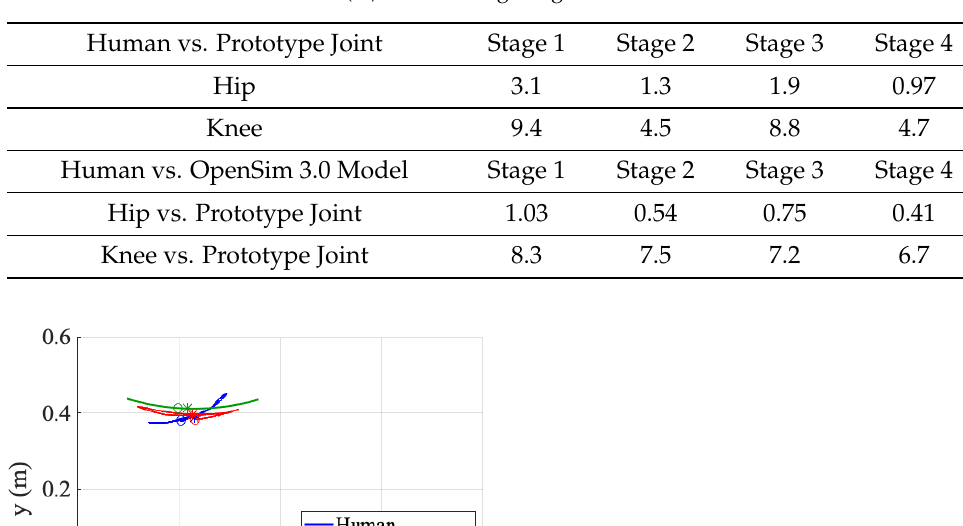
Table 2. Maximum absolute error (%) for each stage of gait.